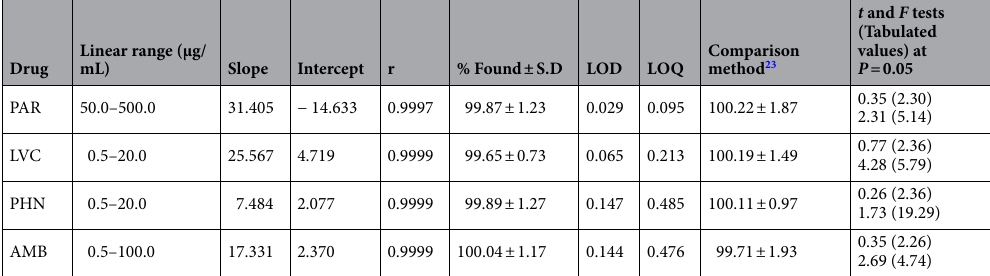
Table 2. Analytical parameters and assay results for determination of the investigated drugs in pure form by the suggested and comparison method.